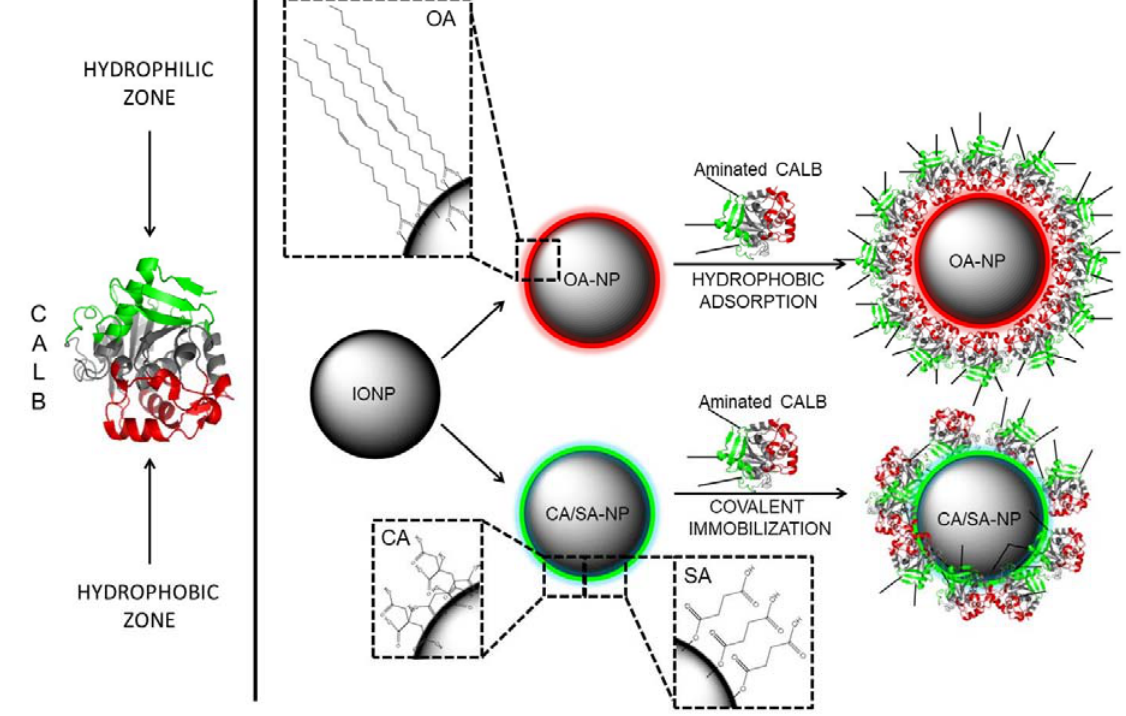
Figure 2. Controlled immobilization of chemically modified CALB on tailor-made magnetic iron oxide nanoparticles (IONP). (OA: oleic acid; CA: citric acid; SA: succinic anhydride).